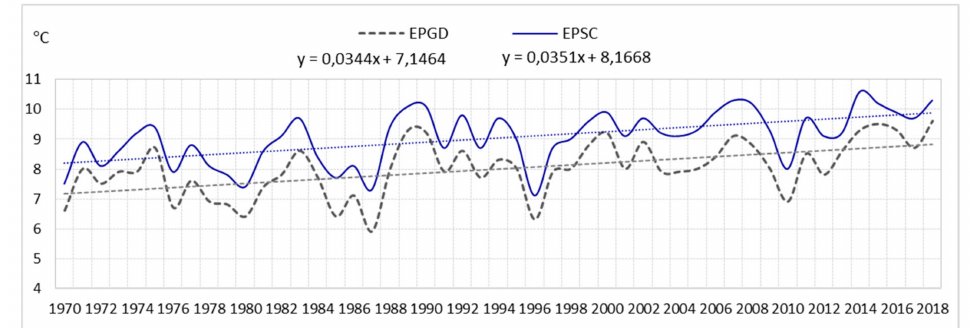
Figure 9. Average annual air temperature and linear trend in EPGD and EPSC